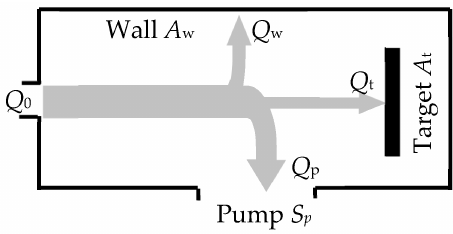
Figure 4. Flows on all surfaces.